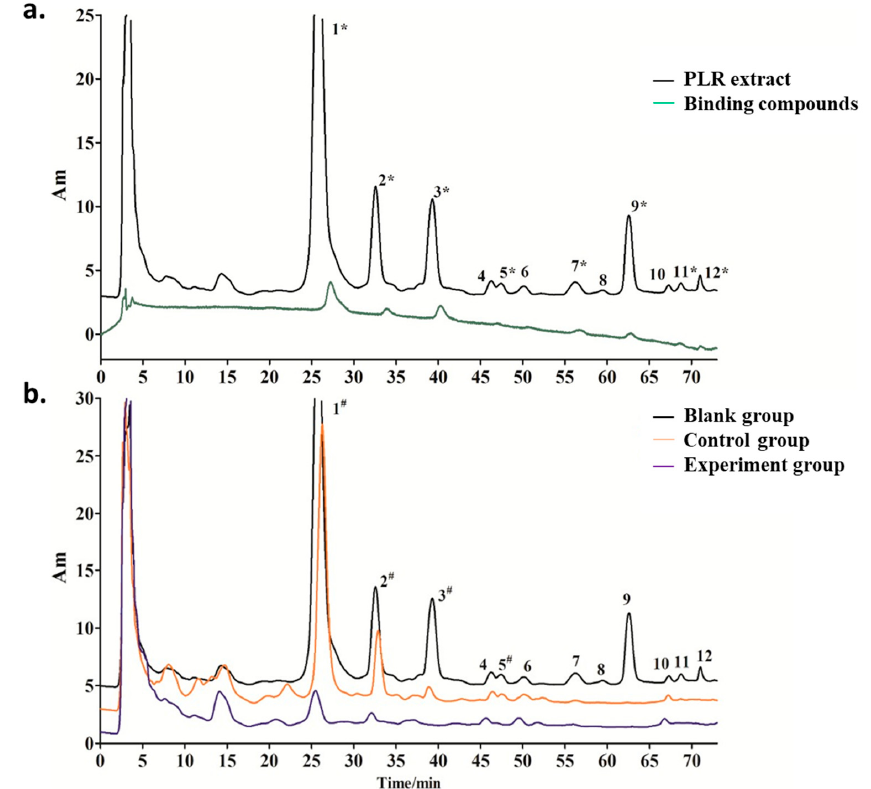
Figure 2. HPLC analysis: ( a ) HPLC chromatogram of Puerariae lobatae Radix extract (black) and the filtrates from test groups (green): the decrease peaks of test groups comparing with PLR extract indicate the binding compounds; ( b ) HPLC chromatogram of the filtrates respectively collected from blank groups (black), control groups (orange) and experiment groups (purple) .